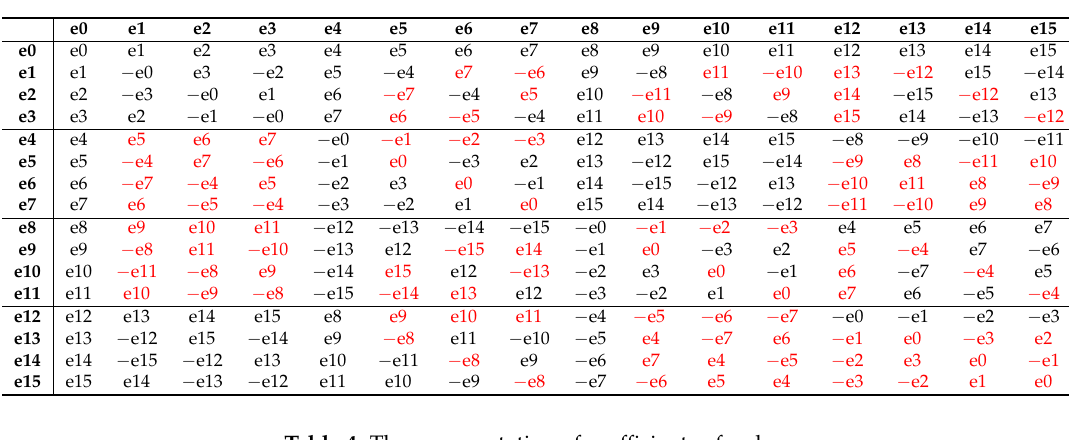
Table 4. The representation of coefficients of